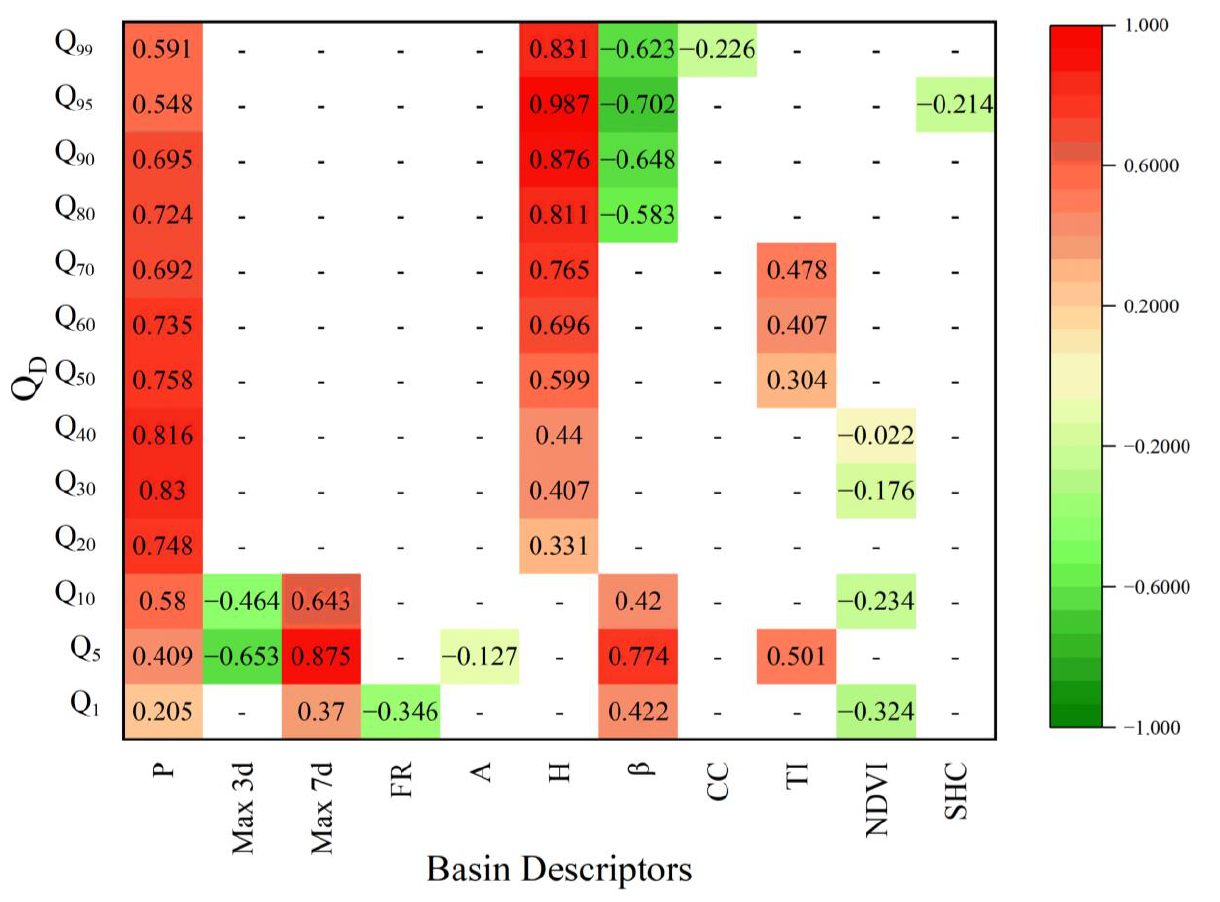
Figure 4. Results of the stepwise regression. The stepwise regression was performed on 23 basin descriptors for each of the 13 percentile flows and only 11 descriptors remained. The numbers rep- resent standardized regression coefficients. No value (-) means that the basin descriptor is not sig- nificant enough for this percentile flow and is